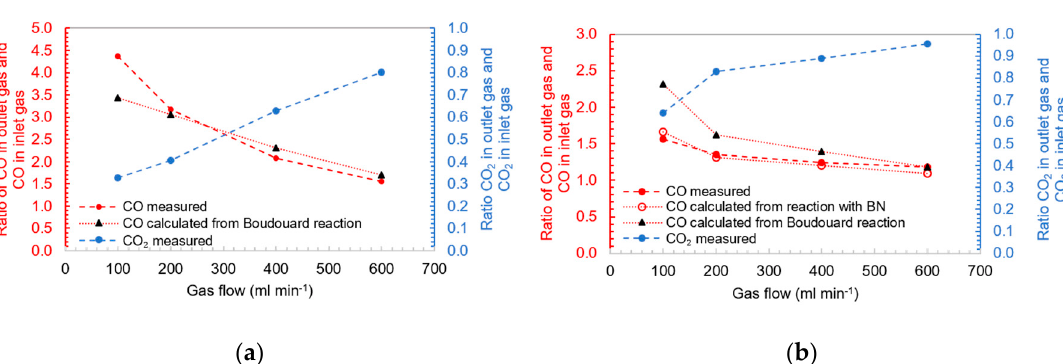
Figure 7. The ratio of concentration in outlet gas and inlet gas for both CO and CO 2 : ( a ) Setup 1 and ( b ) Setup 2. For both setups, data indicated by red and blue solid circle markers represent measured CO and CO 2 concentration, respectively. Black triangular marker represents calculated CO concentration in outlet gas if CO 2 loss was only due Boudouard reaction. Non-filled red circle marker in ( b ) represents calculated CO concentration if CO 2 loss was only due to its reaction with